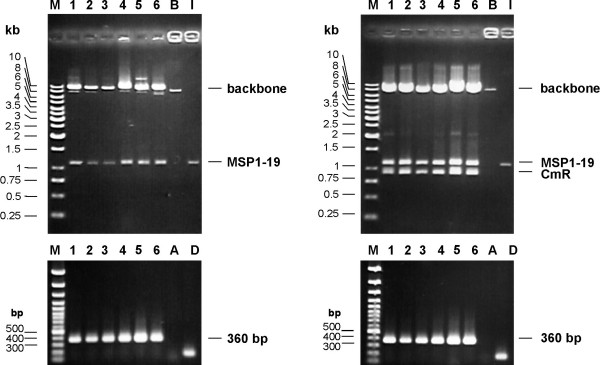
Analysis of the Cre-recombinase reaction with novel donor and acceptor plamids. Results of the Cre-recombinase reactions using pKOIX, pAX, and pDL-MSP119, respectively. Left column: Analysis of recombinant pAX-MSP119 clones. Top: The restriction analysis of recombinant pAX clones with XhoI and SacI and are shown. The analyzed positive clones (1–6) have an 8.6 kb backbone and a 1.2 kb insert. The vector backbone without the insert (control B) and the donor plasmid insert (MSP119) are shown in lanes B and I. Bottom: The diagnostic PCR confirms that all analyzed clones are positive, because the amplification of the specific 360 bp fragment is only possible in recombinant clones. The acceptor control (A) is negative and the fragment in the donor control (D) is an unspecific artefact (200 bp). Right column: The analogous approach as shown in the left column with the acceptor plasmid pKOIX instead of pAX. The analyzed positive clones carry a 7.9 kb backbone and the 1.2 kb insert. The additional band at 1.0 kb is due to a SacI site in the Cm resistance. Lanes B and I show the used backbone (pKOIX) and the 1.2 kb insert (MSP119). The diagnostic PCR leads to the specific 360 bp fragment like in the pAX-MSP119 approach. The 200 bp fragment in the donor control, (D) is an unspecific artefact. The acceptor control (A) is negative.